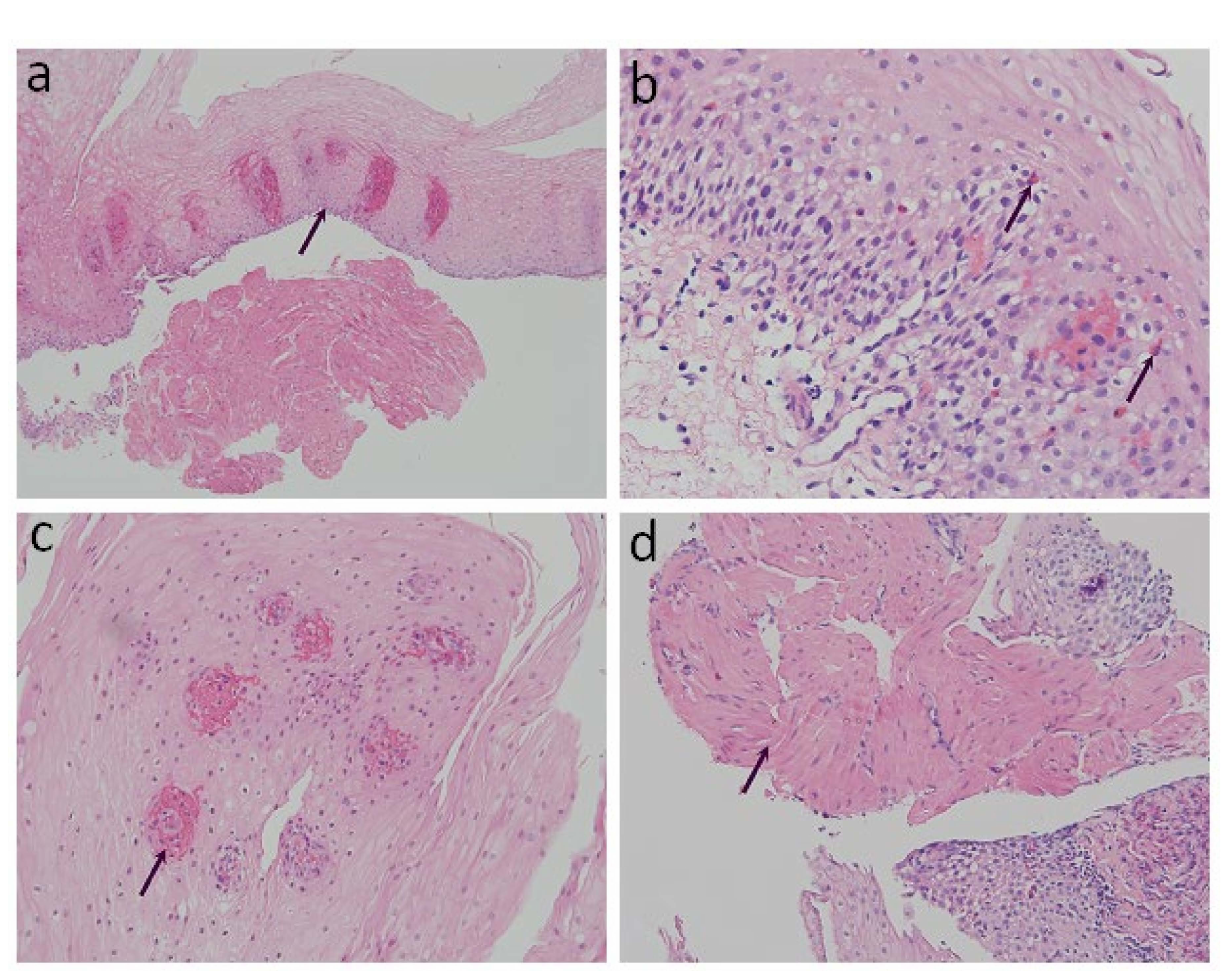
Figure 1. Histopathological findings on esophageal mucosa biopsies. (arrow) (H&E stain): ( a ) Basal cell hyperplasia or papillae elongation (100 × magnification); ( b ) Eosinophilic infiltration (200 × magnification); ( c ) Petechiae formation (400 × magnification); ( d ) Hypertrophy of the muscularis mucosae (200 ×